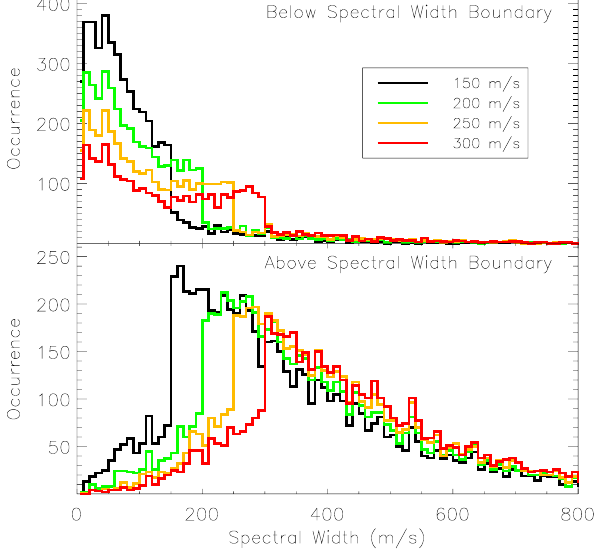
Fig. 15. The distribution of spectral width values below and above the spectral width boundary as determined by applying algorithm 3 to one year of data (from 1998) from beam 8 of the Halley Su- perDARN radar. Only cusp-region spectral widths (from 08:00– 12:00MLT), from within 10 range gates of the estimated boundary position, are shown. The four different lines represent the results from using four different spectral width threshold values (150, 200, 250, and 300 m/s) to identify the